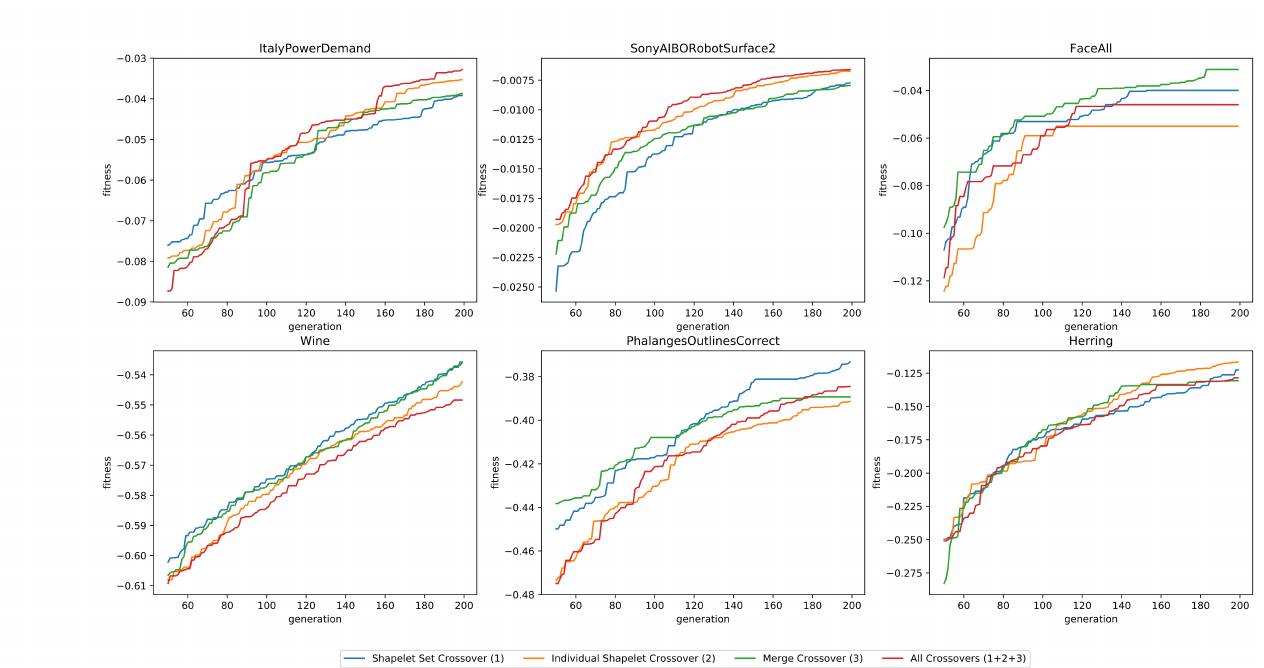
Figure 7. The fitness as a function of the number of generations, for six datasets, using four different configurations of crossover